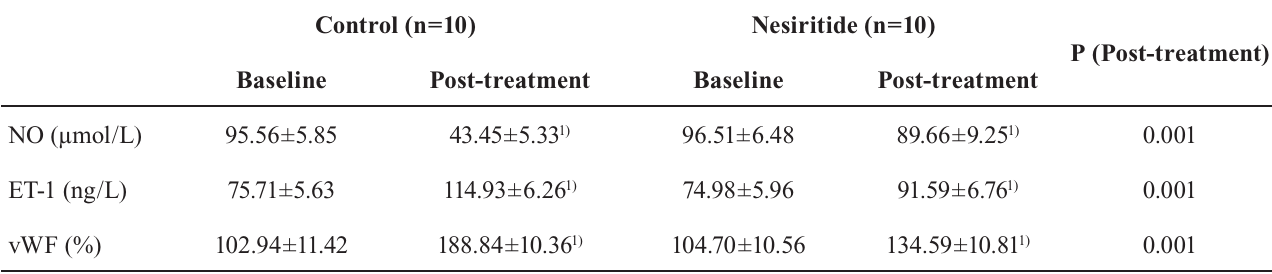
TABLE II - Comparison of plasma ET-1, NO and vWF levels between nesiritide and control